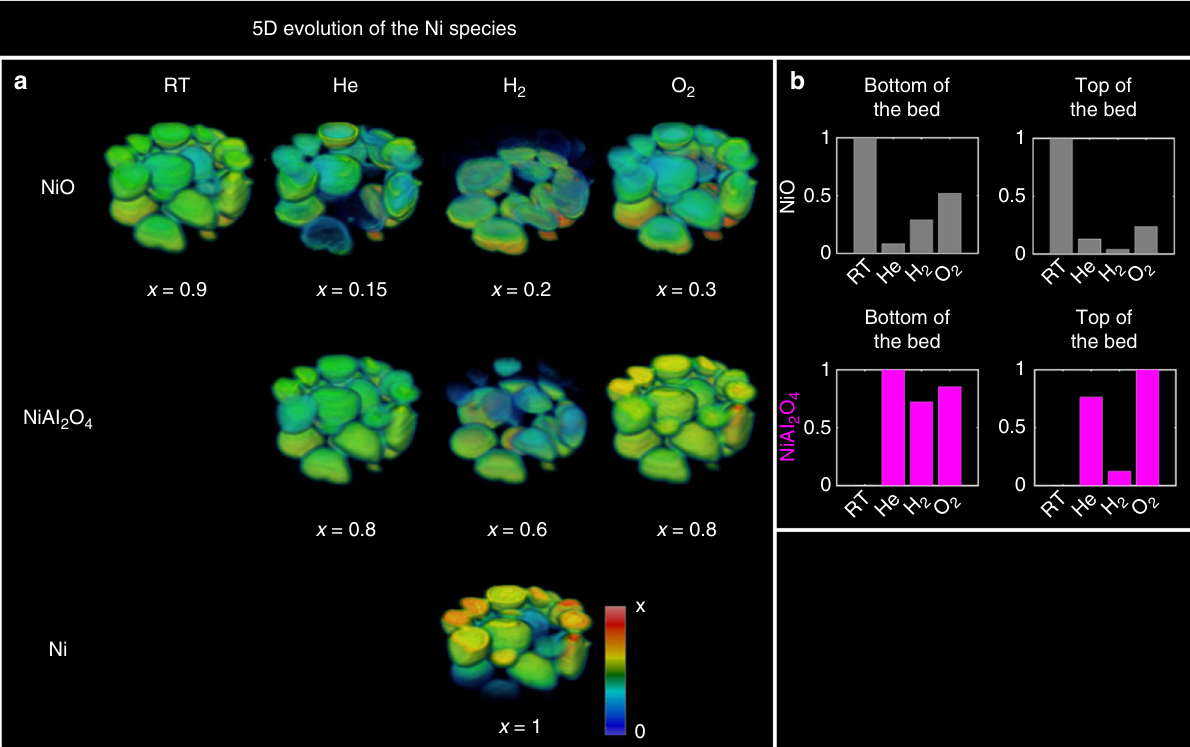
Fig. 6 5D chemical evolution of the Ni-containing species in the catalyst bed. a Phase distribution volumes of NiO, NiAl 2 O 4 and Ni as obtained from the Rietveld analysis of the 3D-XRD-CT data collected at the four different operating conditions. The values in the colorbar axes have been chosen to achieve the best possible contrast. b Solid-state evolution of the NiO and NiAl 2 O 4 phases at the bottom and top of the catalyst bed during the redox experiment (ie, XRD-CT scan 1 and 30). The results presented in this fi gure correspond to the Rietveld analysis of ca. 1.2 × 10 6 diffraction